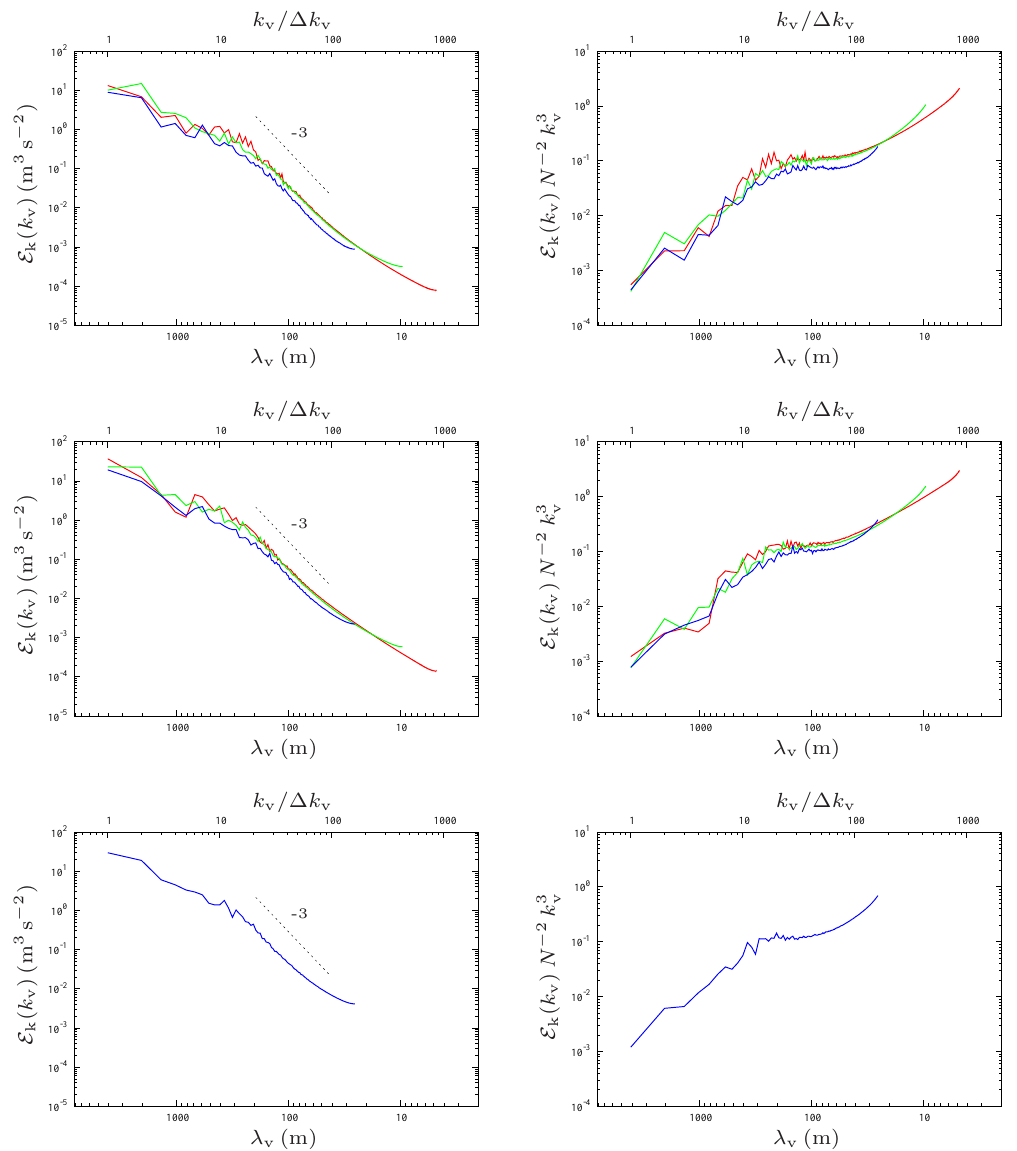
Figure 13. Vertical turbulent kinetic energy spectra (left panels) and compensated spectra (right panels). From top to bottom: strong forcing, moderate forcing, and weak forcing case. Red lines: 1 = 2m; green lines: 1 = 4m; blue lines: 1 =